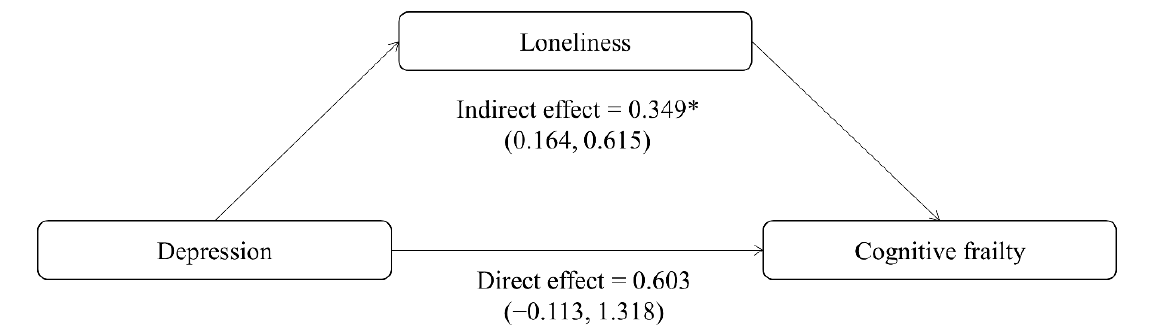
Figure 1. Mediating effects of loneliness on the association between depression symptoms and cognitive frailty in community-dwelling older adults. 95% confidence intervals are presented. Models control for gender, age, BMI, education, marital status, household arrangement, monthly income, cigarette smoking, alcohol drinking, polypharmacy, annual check-up, and sleep disorders. * p < 0.05.